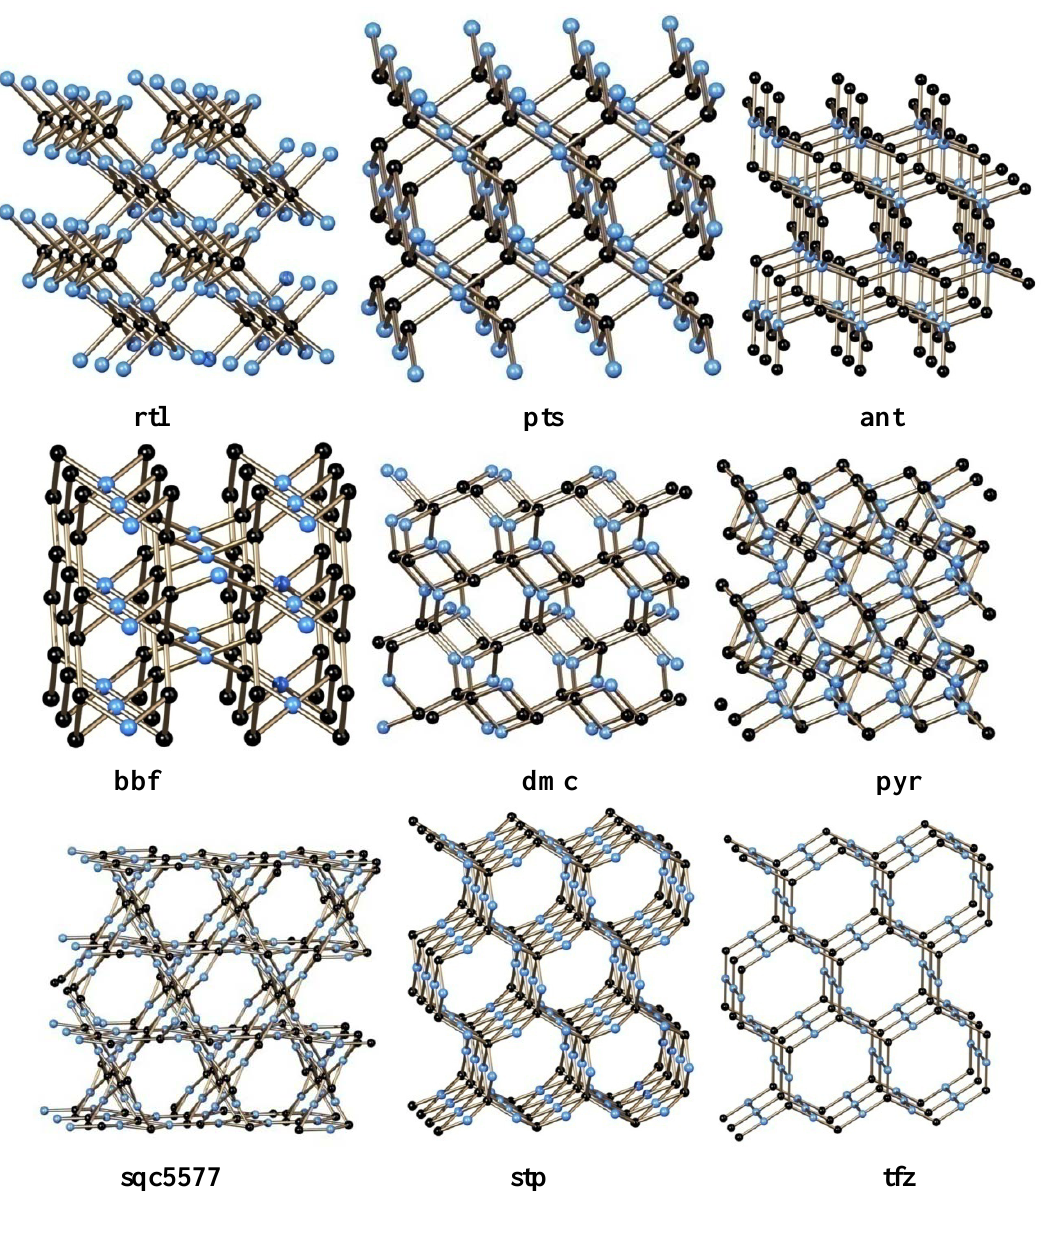
Figure 5. Topology of the binodal three-dimensional